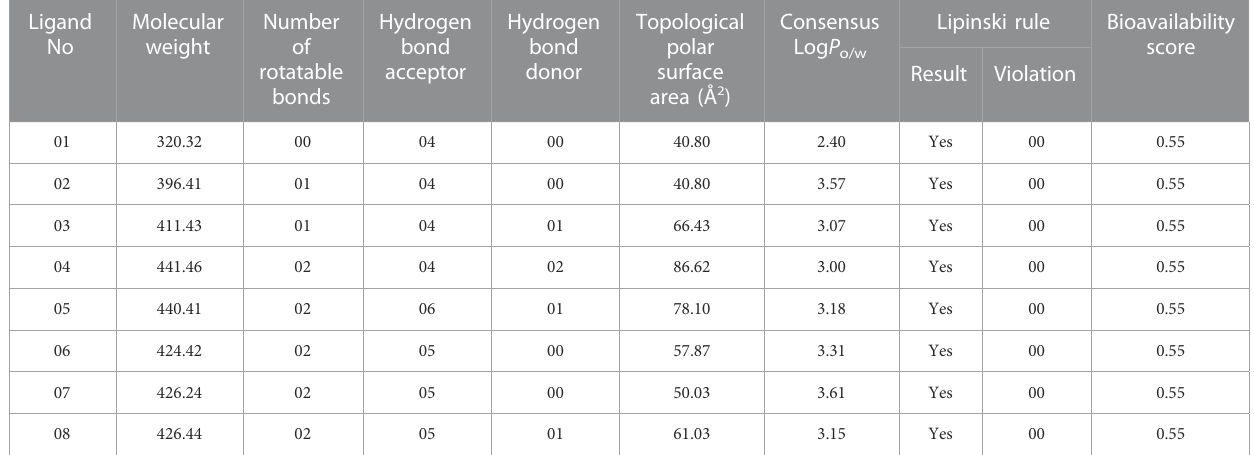
TABLE 1 Summary of ligands calculated results for Lipinski rule, pharmacokinetics and drug likeness activities. Ligand